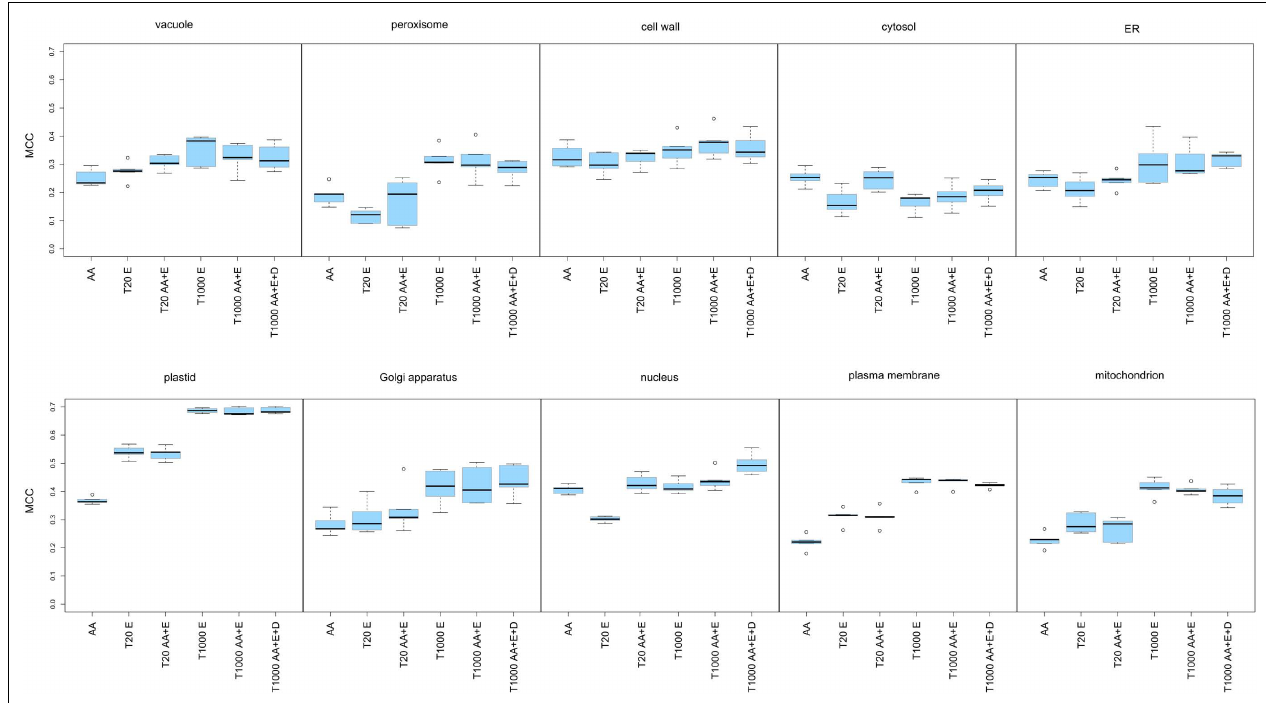
features selected from the amino acid composition and the expression data (T20 AA + E), the top 1,000 features selected from the expression features (T1000 E), the top 1,000 amino acid composition and expression features (T1000 AA + E) and the top 1,000 features selected from amino acid composition, dipeptide composition and expression data (T1000 AA + D + E). For each predictor the Matthews’ correlation coefficients from the 5 cross-validation loops are visualized as a box